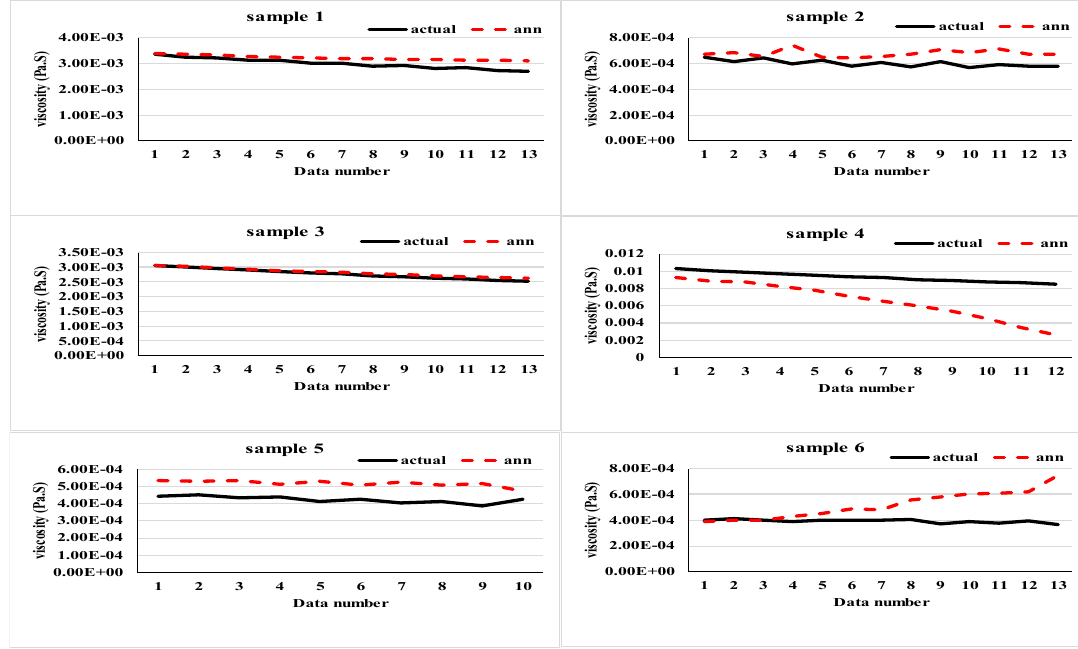
Figure 8. Viscosity validation of ANN and experimental data.